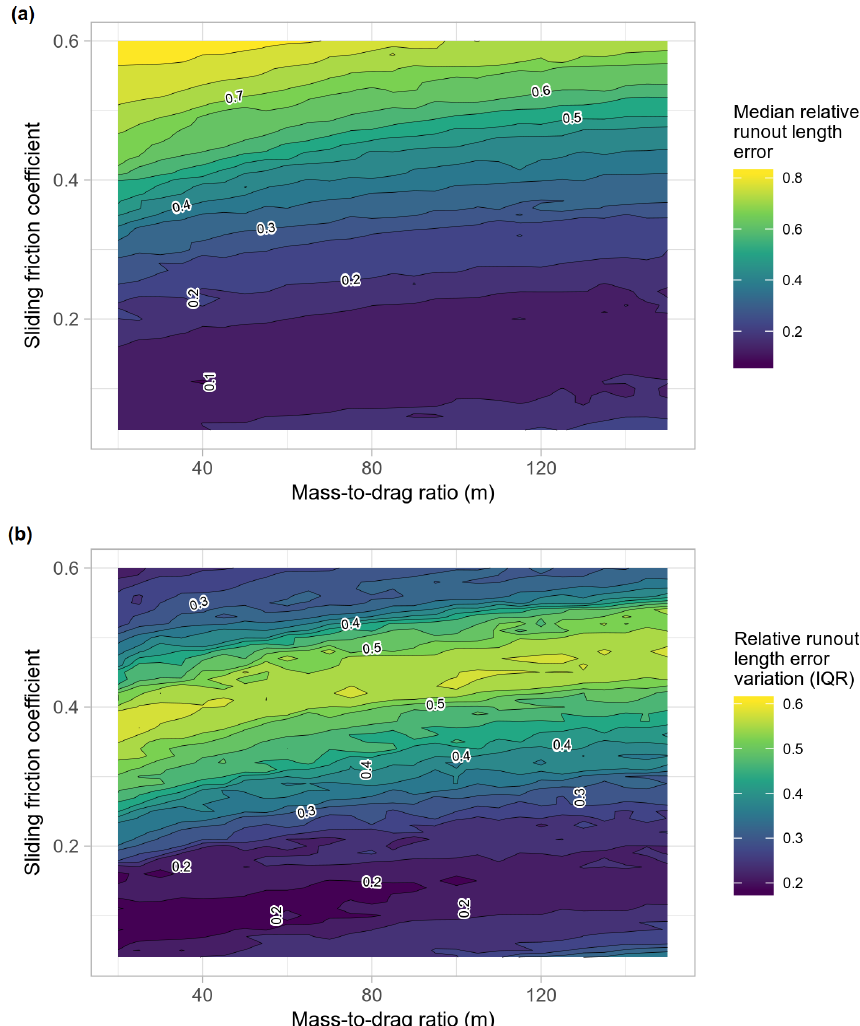
Figure 6. Density contour plots of parameter optimization of sliding friction coefficient µ and M/D in the PCM model, illustrating median relative runout length errors (a) and the associated variations in relative error (b) using the